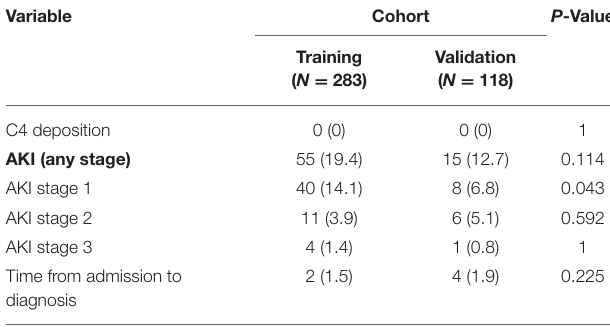
TABLE 1 | Baseline characteristics of patient